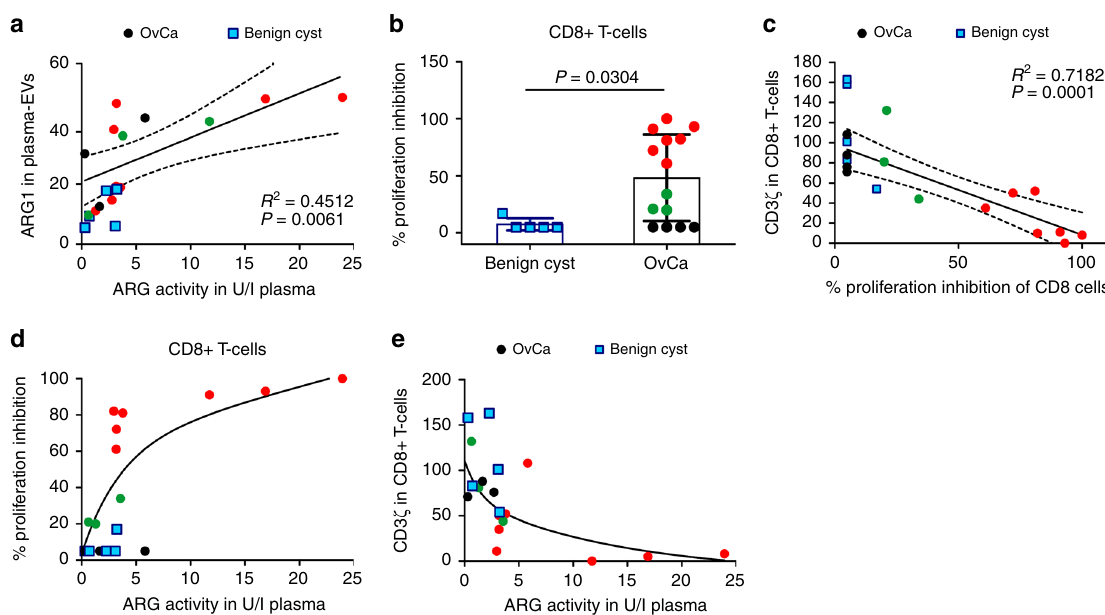
Fig. 3 ARG1-containing EVs contribute to systemic immune suppression in OvCa patients. a Correlation of relative expression of ARG1 in plasma-derived EVs (isolated from n = 14 OvCa patients [circles] and n = 5 patients with benign cyst of the ovary [squares]) and plasma ARG activity. R 2 value and P values calculated with GraphPad Prism 6.0. Dotted lines mark 95% con fi dence intervals. b – e Black circles mark OvCa samples with no CD8 + T-cell proliferation inhibition ( n = 4), green circles ( n = 3) — moderate proliferation inhibition, and red circles ( n = 7) — complete or nearly complete proliferation inhibition. Blue squares mark benign cyst samples. b Proliferation of peripheral blood CD8 + T-cells in n = 14 OvCa patients and n = 5 patients with benign ovarian cyst normalized to the mean proliferation of n = 5 healthy controls. Data show means ± SD, P- value calculated with Mann – Whitney U -test. c Correlation of the peripheral blood CD8 + T cell percentage of proliferation inhibition and CD3 ζ levels evaluated in fl ow cytometry. R 2 value and P value calculated with GraphPad Prism 6.0. Dotted lines mark 95% con fi dence intervals. d Percentages of peripheral blood CD8 + cells proliferation inhibition as a function of ARG activity in plasma of n = 14 OvCa patients and n = 5 patients with benign cyst of the ovary. e CD3 ζ levels evaluated in fl ow cytometry as a function of ARG activity in the plasma of n = 14 OvCa patients and n = 5 patients with benign cyst of the ovary. Source data are provided as a